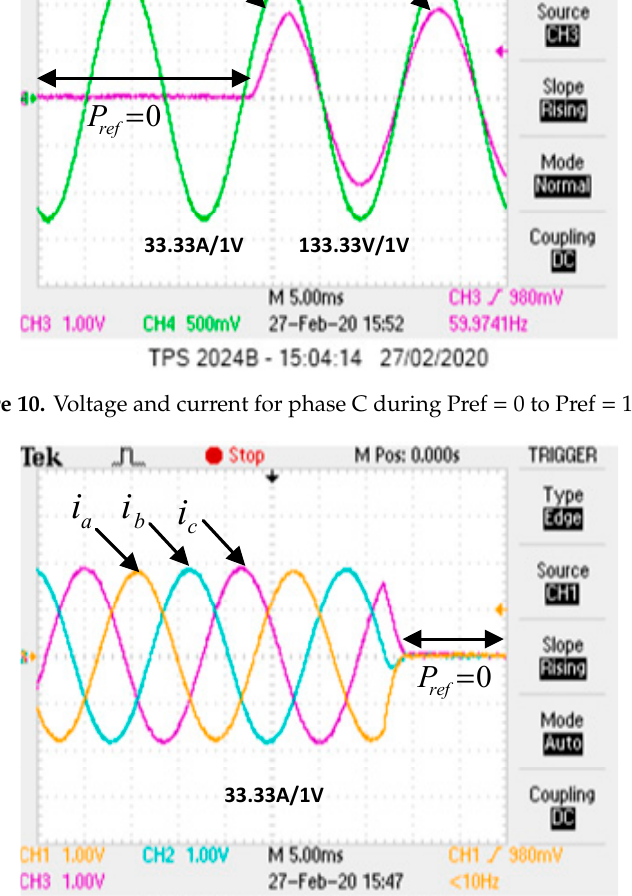
Figure 11. Three-phase current during a stop from Pref = 10 kW to Pref = 0 kW.